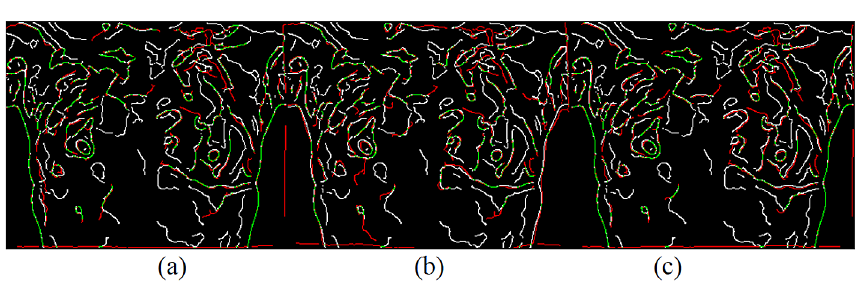
Figure 12. Canny overlays of TYPE IV images obtained with ( a ) the proposed ( b ) Lee et al . ( c ) Optical flow.